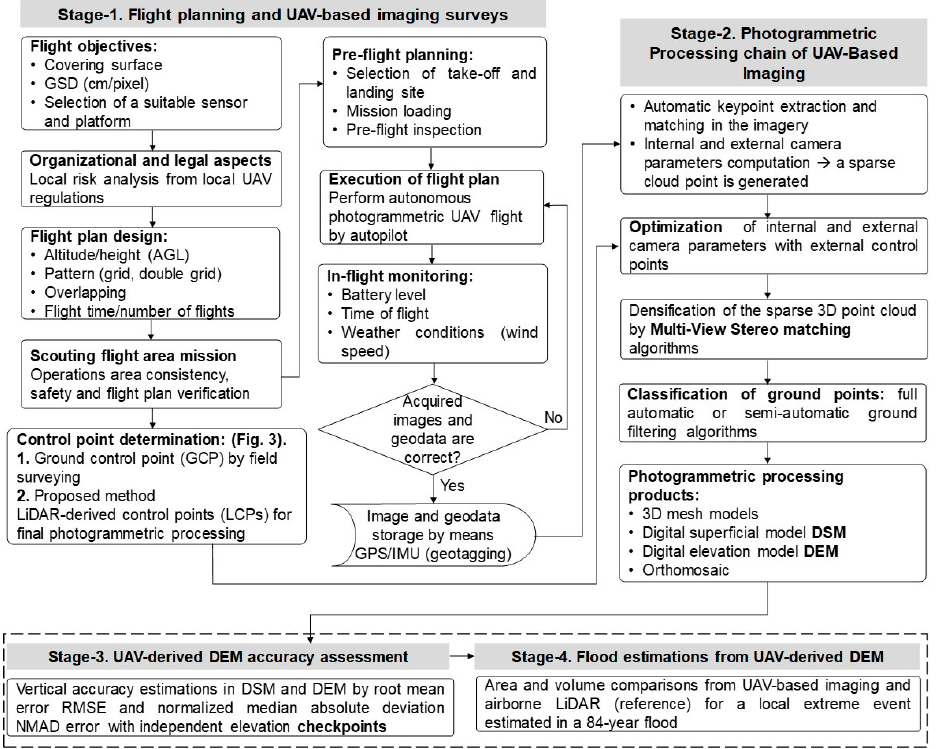
Figure 2. General outline of the methodology.